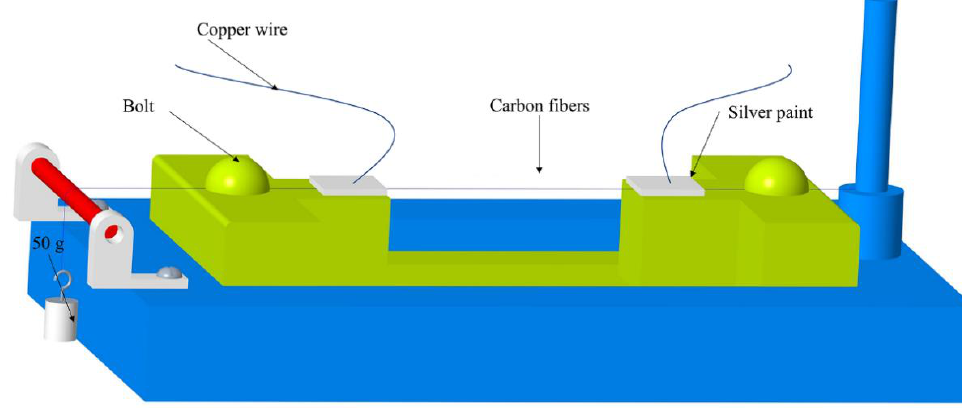
Figure 2. A scaffold for fiber testing.